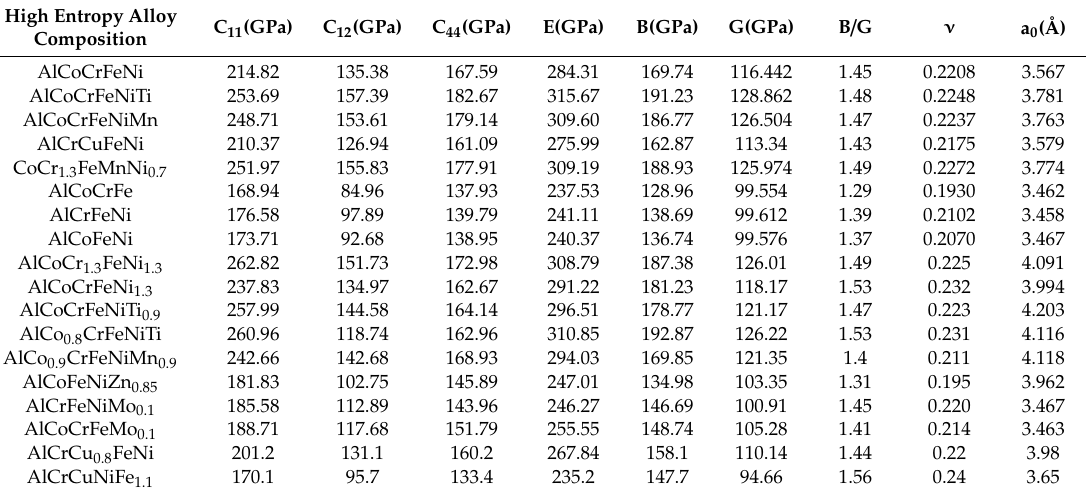
Table A3. DFT calculated three independent elastic constants (C ij ), elastic (E), bulk (B), shear modulus (G), Poisson’s ratio ( ν ) & equilibrium lattice distance (a 0 ) for the following HEAs. High Entropy Alloy